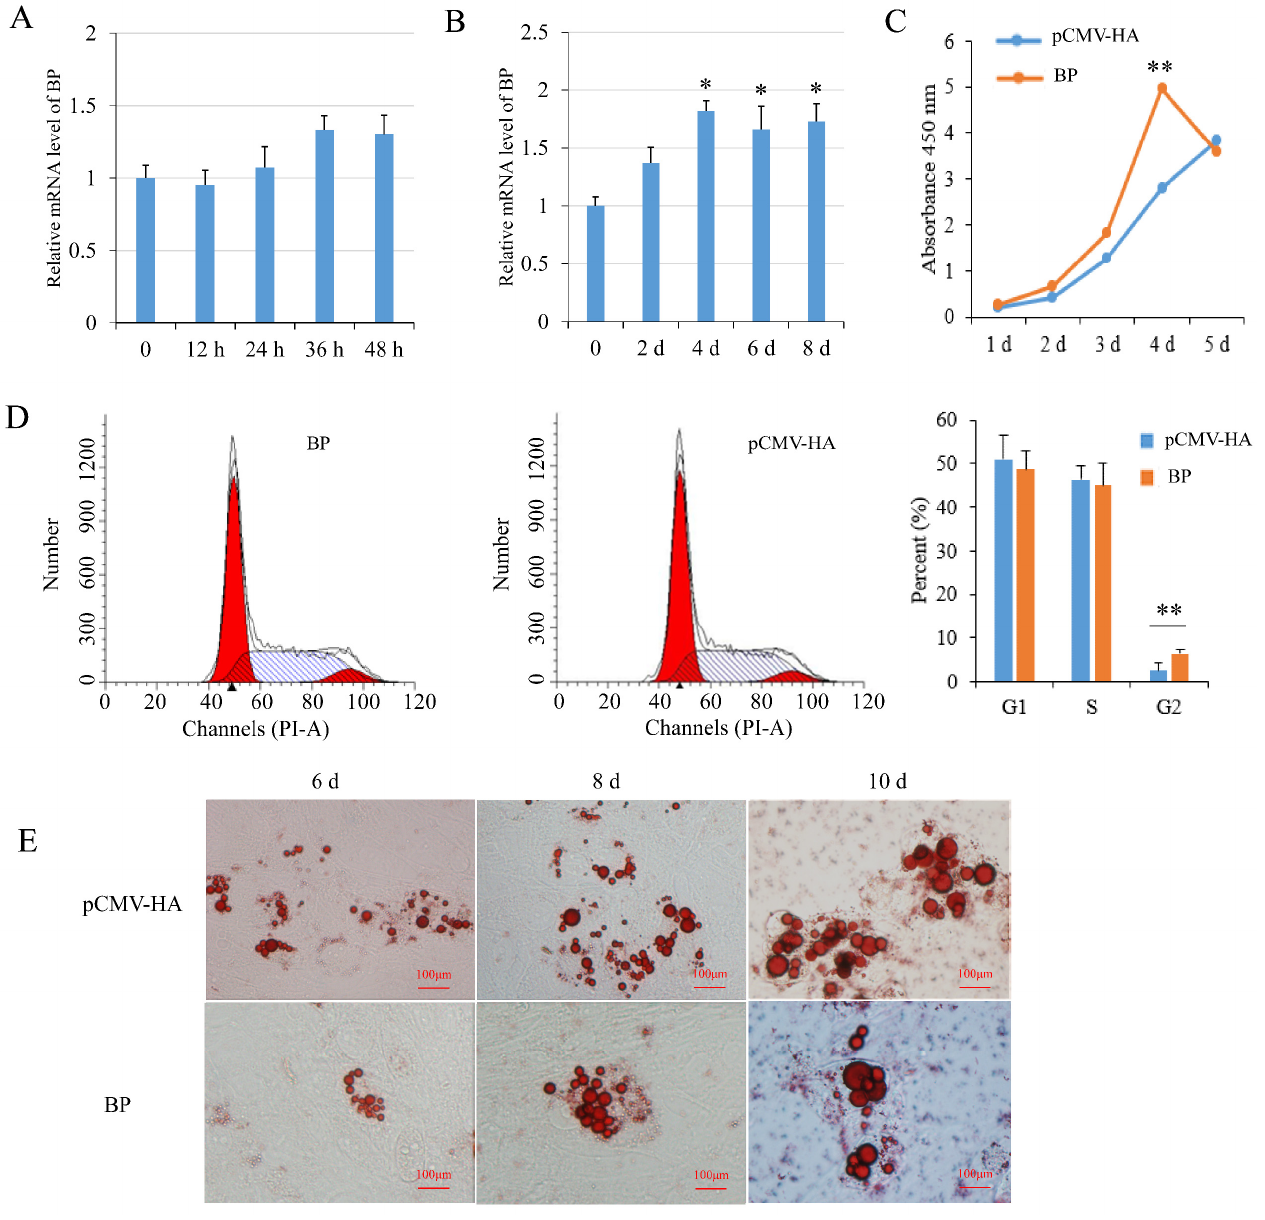
Figure 4. Effects of BCL2L2-PABPN1 (BP) on subcutaneous preadipocyte proliferation and differen- tiation. ( A ) Expression of BP during porcine preadipocyte proliferation determined with real-time PCR. ( B ) Expression of BP during porcine preadipocyte differentiation determined with real-time PCR. ( C ) Effect of BP on cell proliferation measured by CCK-8 assay. ( D ) Effects of BP on cell cycle measured with flow cytometry. ( E ) Oil red O staining of differentiated adipocyte. * and ** indicates p < 0.05 and p < 0.01, respectively, compared with control groups. The bar is 100 μ m.